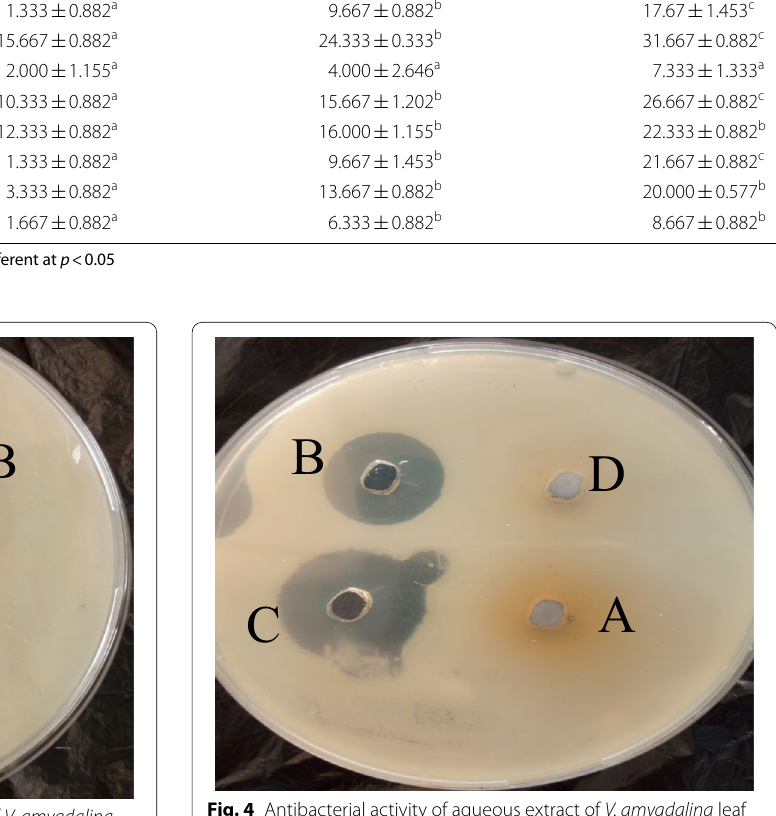
25 mg/ml, B 50 mg/ml, = = =